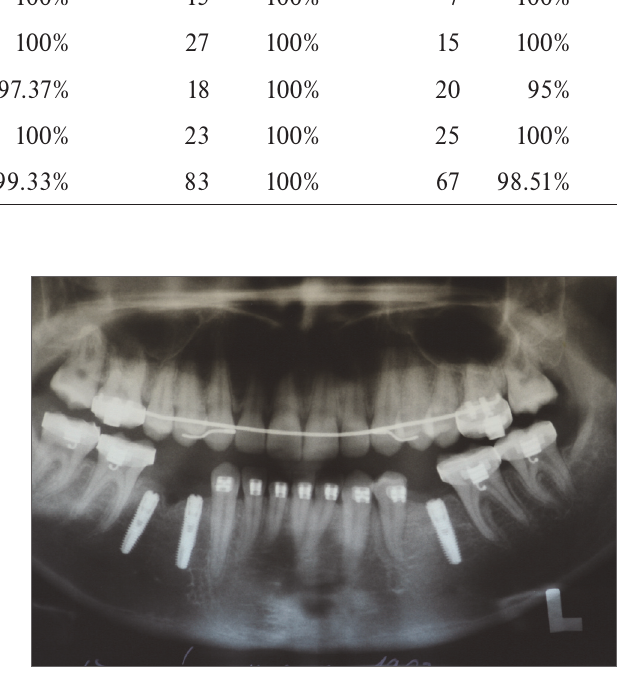
Fig. 4. State in a patient with hypodontia and a limit value of tolerance to titanium.